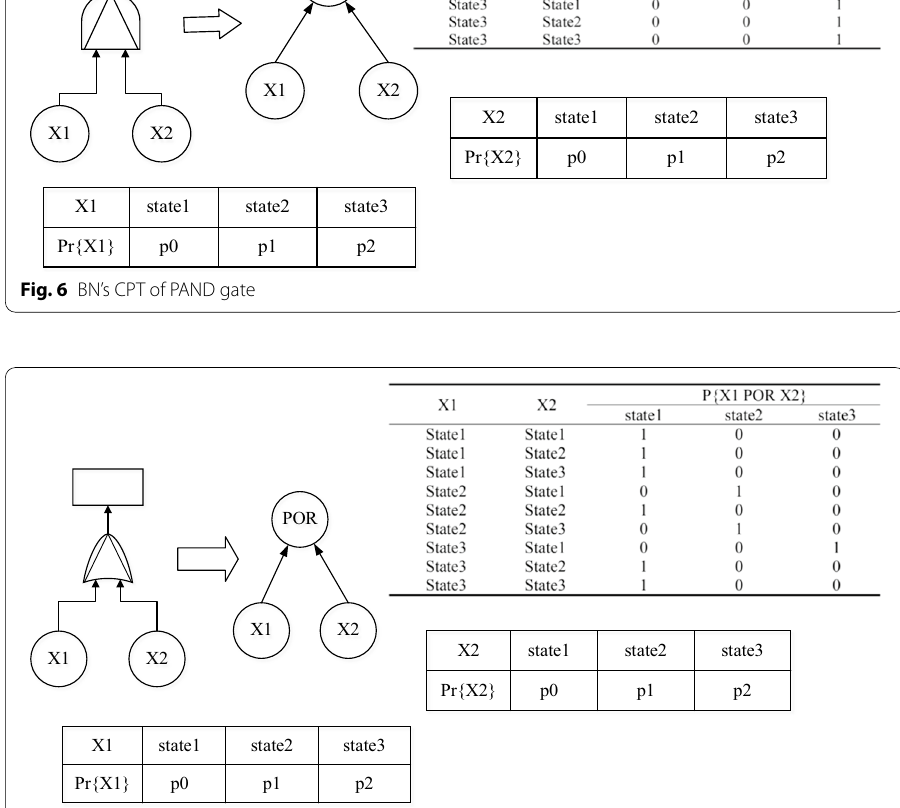
Fig. 7 BN’s CPT of POR